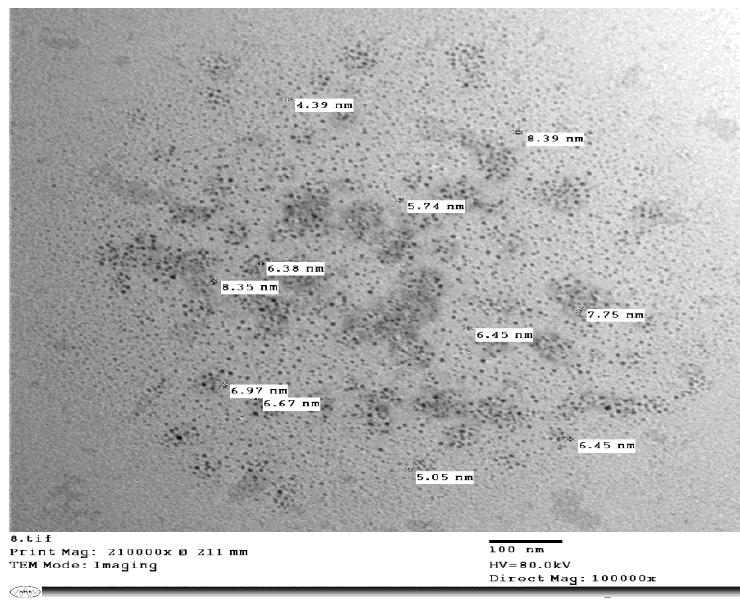
Figure 2. Silicon nanoparticles.